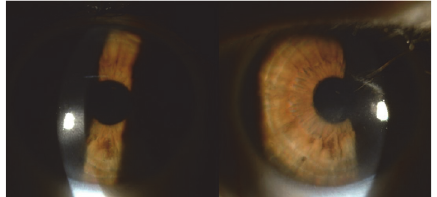
Figure 1: Incomplete eyelid closure.